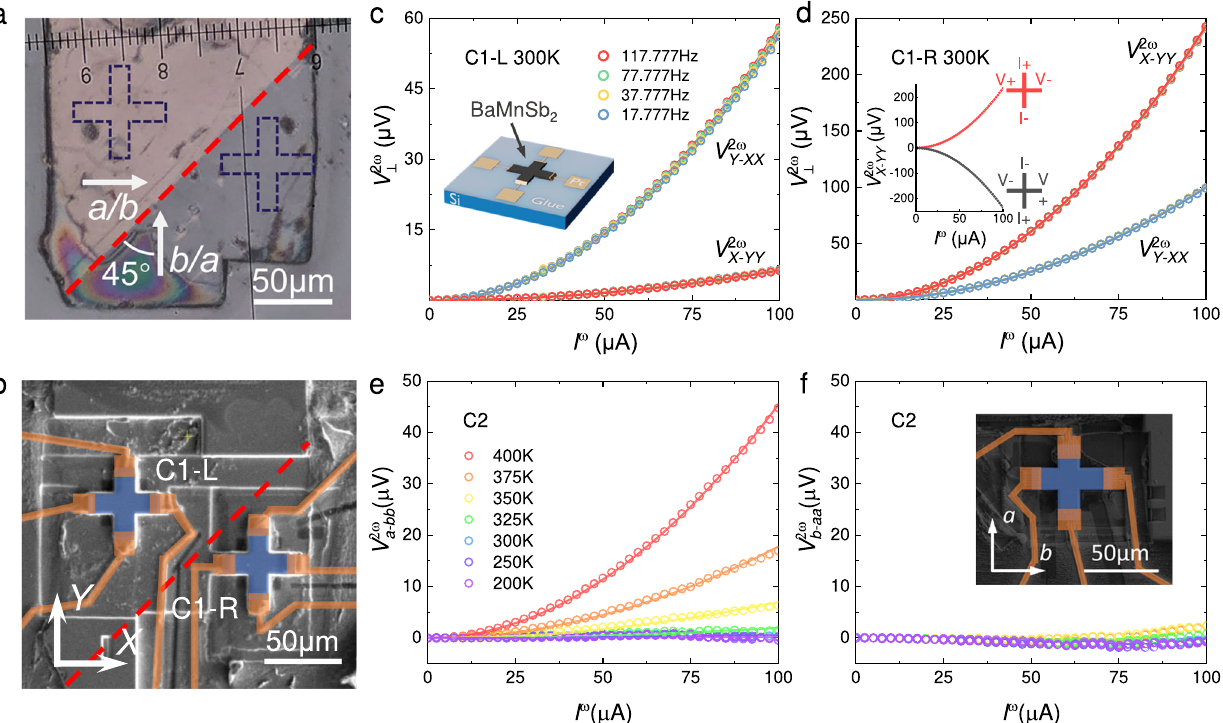
Fig. 2 | Current direction dependent second-harmonic Hall voltage response measured on cross-like Hall devices of BaMnSb 2 . a Optical image of a BaMnSb 2 single-crystalline fl akewithtwomajordomains.The90°domainwallismarkedwith adashedline.Thewhitearrowsindicatethecrystallographicaxesinbothdomains. Thebluedashedlinesshowthelocationsofthetwocross-likedevicesfabricatedon thiscrystal. b The SEM image of the cross-like Hall devices carved using FIB on the crystal shown in a . Two devices (marked in blue) are located on the two different sides of the domain wall. The depositedPt contacts and lines are shown in orange. c , d The second-harmonic Hall voltage V 2 ω ? vs. the input ac current I ω curves at 300K forthe two devices shown in b (C1-L & C1-R). V 2 ω Y (cid:2) XX and V 2 ω X (cid:2) YY refers to V 2 ω ? measured with I ω applied to the X - and Y -axis, respectively. Both V 2 ω Y (cid:2) XX and V 2 ω X (cid:2)